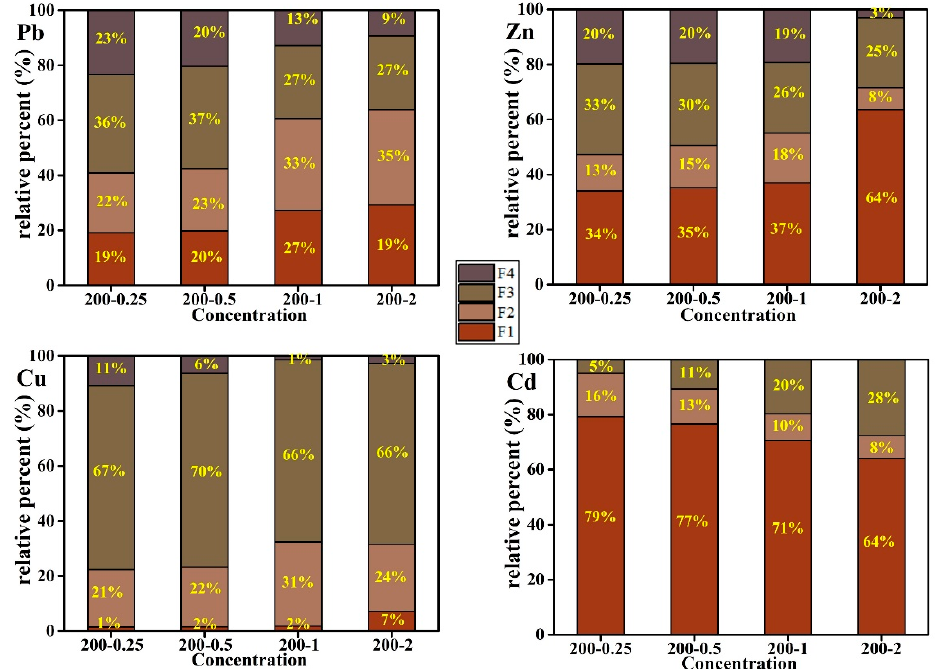
Figure 4. The relative percentages (% of total) of heavy metals (Pb), (Zn), (Cu), (Cd) existing in F1, F2, F3 and F4 in hydrochars with different temperature.